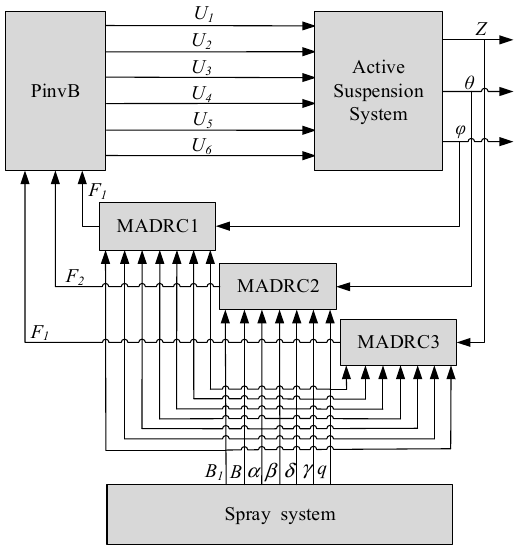
Figure 3. Structure of MADRC system.